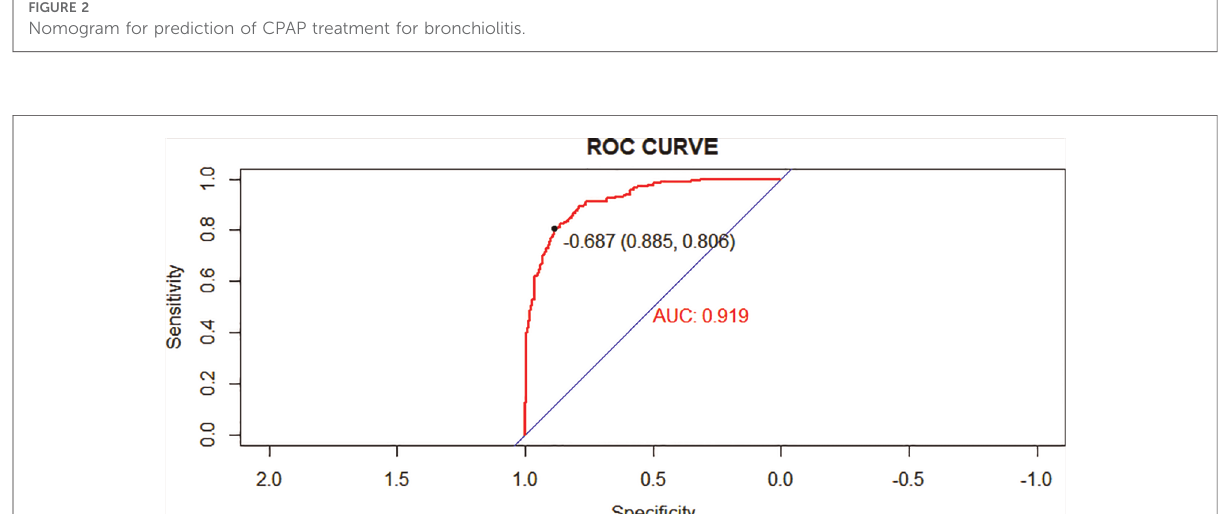
FIGURE 3 Receiver operating characteristic (ROC) curves of the nomogram model in the training cohort.